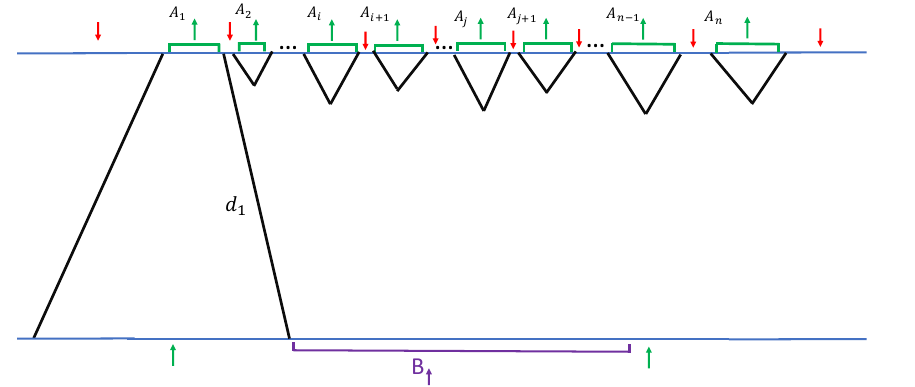
Figure 25 . A domain wall configuration that contributes to (A.4), but not to P ( A ) processes in which O α evolves to operators trivial in the region to the left of A 1